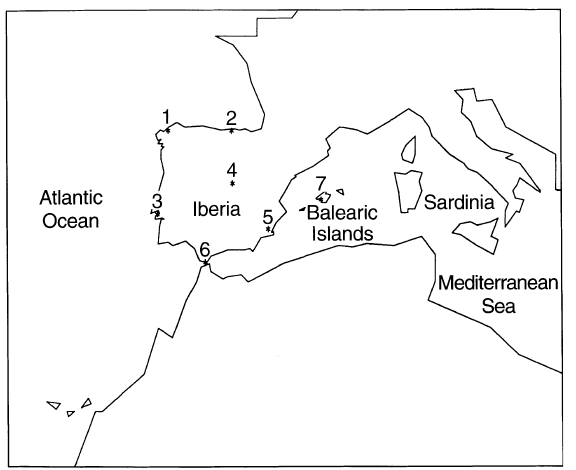
Fig. 1. Map with geographical names referred to in the text indicating location of the seven sounding stations in Iberia by numbers: 1 , La Coru ~ na 2 , Santander; 3 , Lisbon; 4 , Madrid; 5 , Murcia; 6 , Gibraltar; 7 , Palma de Mallorca